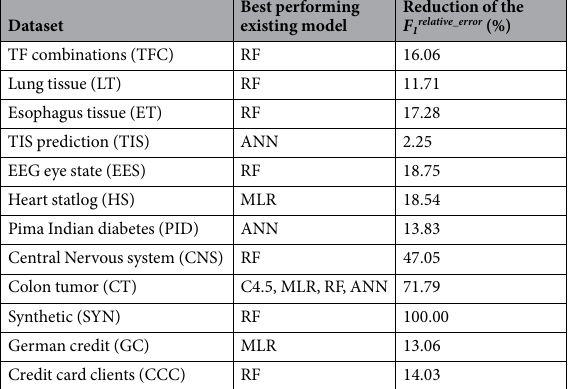
Table 2. Classification error reduction. Comparison between best performing model and OmniGA framework. Best performing existing model refers to the model (MLR, ANN, RF and C4.5) achieving the best F 1 performance in a given dataset. Reduction of the F 1relative error denotes the relative error reduction of OmniGA with respect to the best performing model as defined in Equation